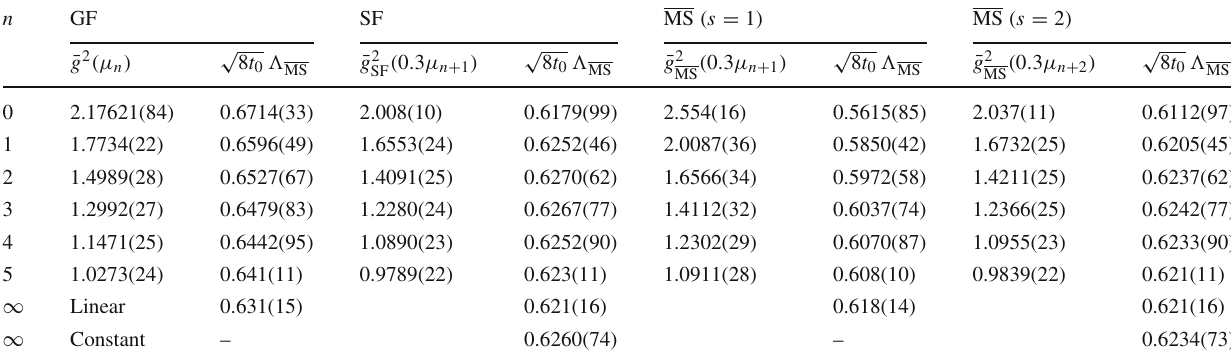
Table 3 Sequence of couplings in different schemes and at different scales ( μ n = 2 n μ ref ) and the corresponding values of text for more details). The values of ¯ g (μ n ) are obtained via a recursive application of the step scaling function in the GF scheme (Eq. (4.17)). The conversion from the GF scheme to the SF scheme is performed non-perturbatively and detailed in Appendix B. The conversion to the